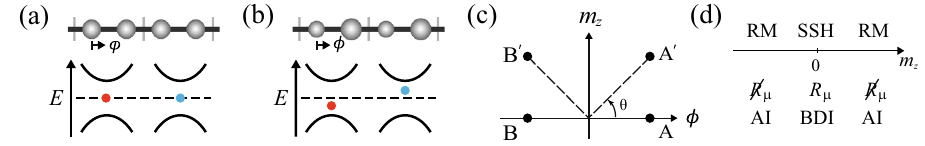
Figure 1. Schematics of atom configurations and band structures for ( a ) SSH and ( b ) RM models. φ is a dimerization displacement that corresponds to a bose field φ( x ) in JR model. Red and blue circles represent isolated soliton and antisoliton modes in the gap, respectively. ( c ) The degenerate vacua for SSH and RM models in the order parameter space of (φ , m z ) : A and B ( A ′ and B ′ ) for the SSH (RM) model. ( d ) Atland–Zirnbauer class 3 and π rotation symmetry with respect to the fermion mass m z . R π ( R / π ) indicates that the π rotation symmetry is preserved